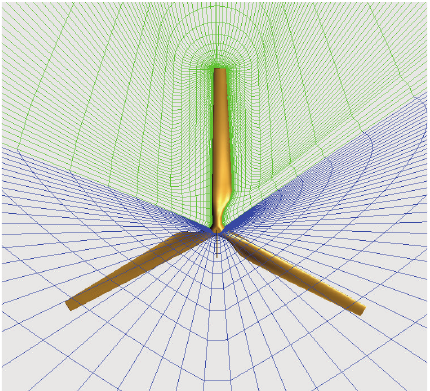
Figure 3: 3D computational grid around 3-blade wind turbine.